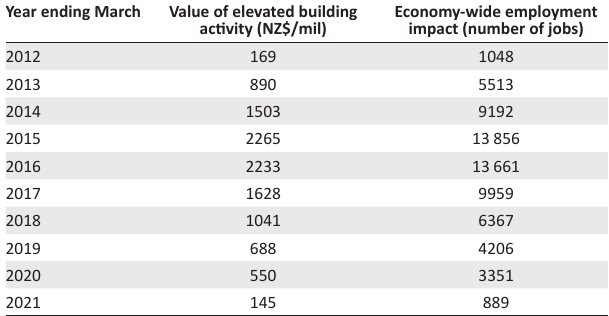
FIGURE 2: Historical value and counterfactual value of building activity, Canterbury. TABLE 1: Input–output results of elevated building activity,